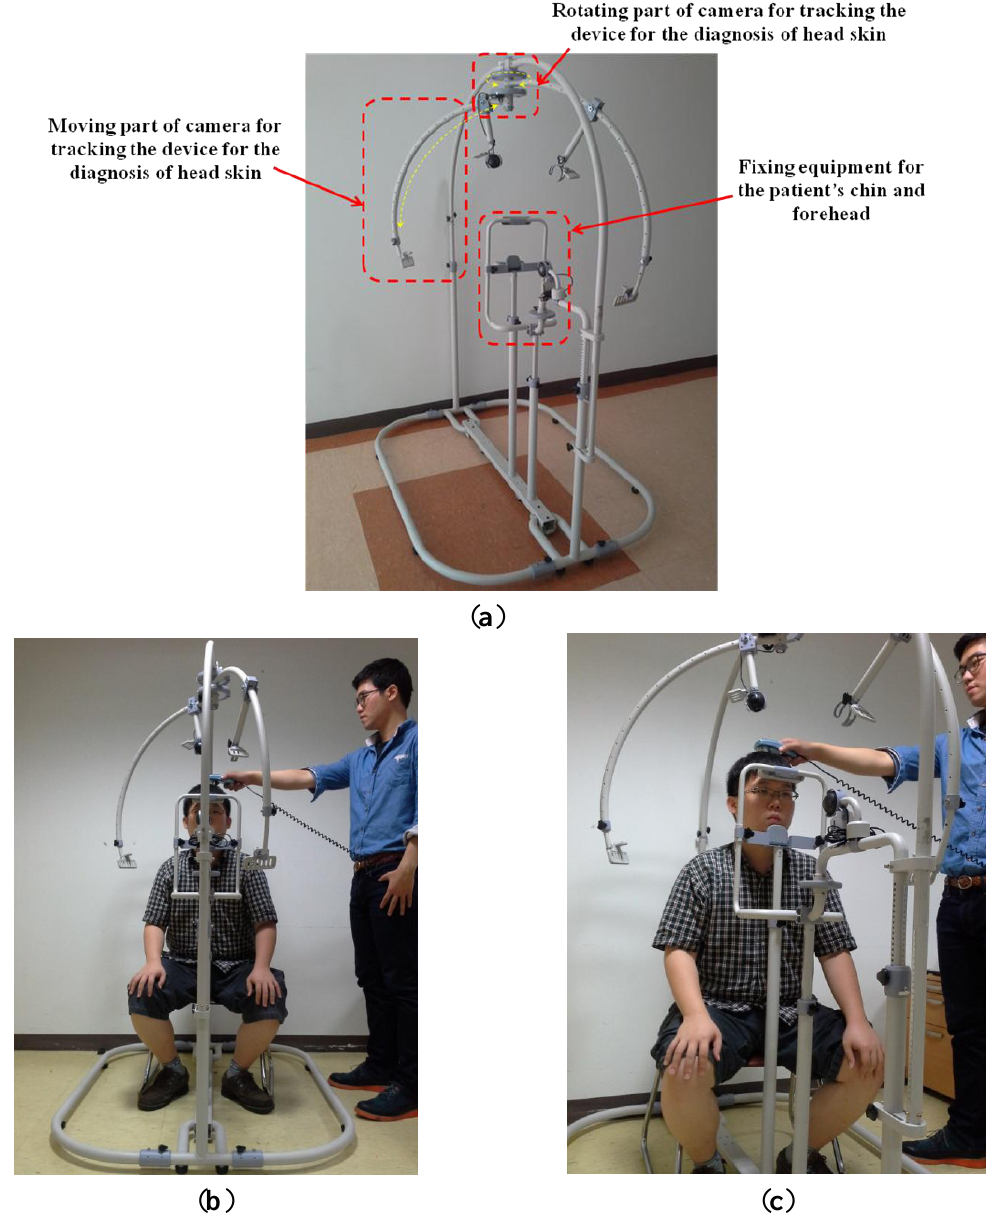
Figure 2. Proposed system for tracking the device to diagnose scalp skin. ( a ) Explanations of each part of proposed system; ( b ) Example of use of the proposed system (frontal view); ( c ) Example of use of the proposed system (another